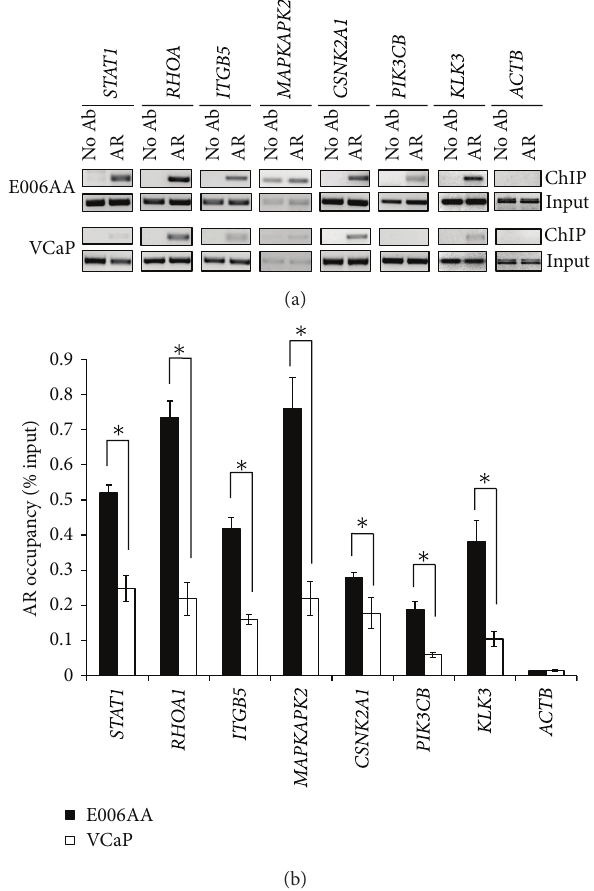
F 3: Enrichment of AR binding to target genes in AA